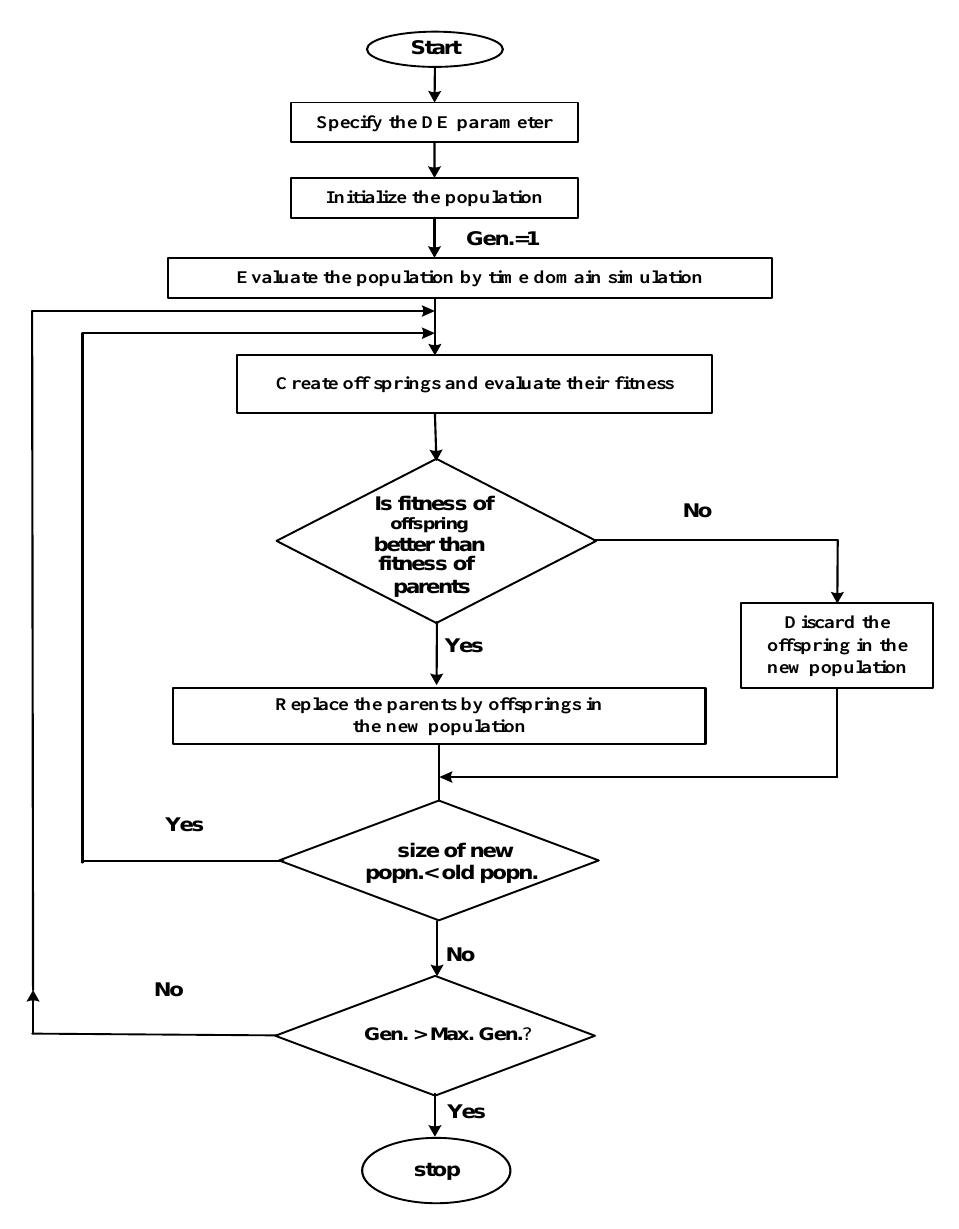
Figure 4. Flow chart of DE optimization.